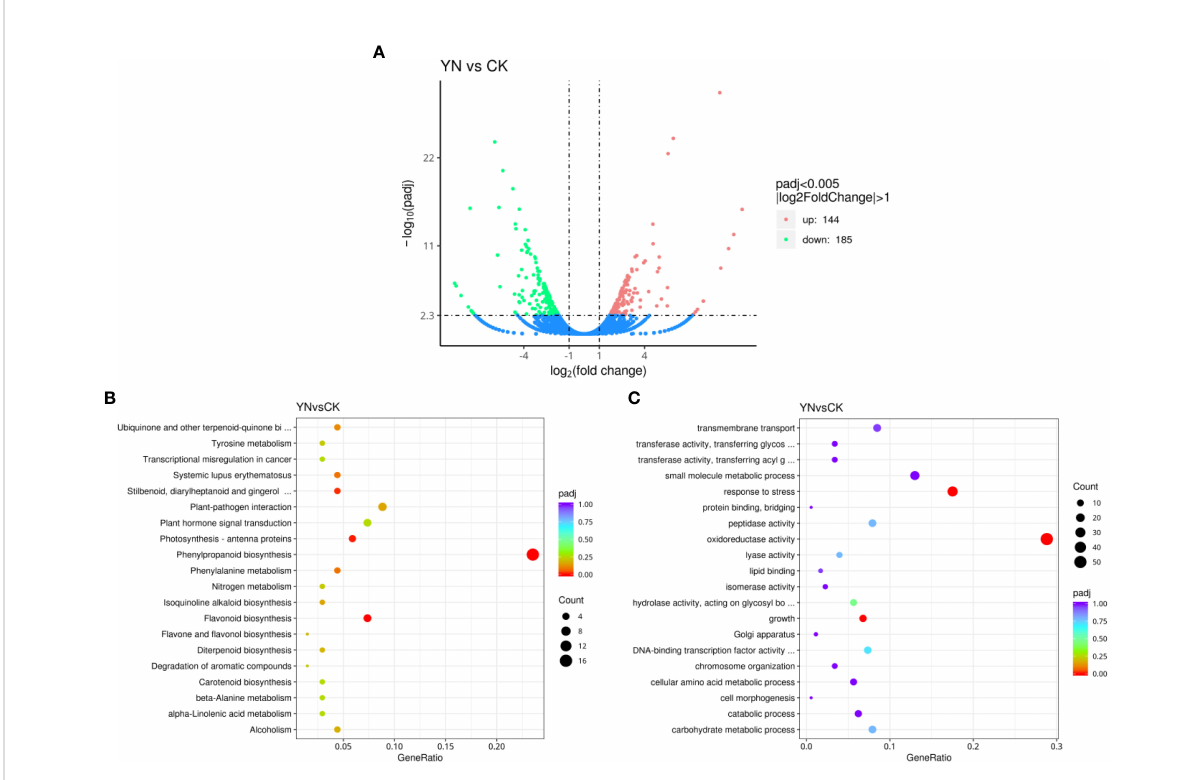
FIGURE 5 Numbers of differentially expressed genes (DEGs) in duckweed between YN (in response to streptomycin) and CK (A) . KEGG (B) and GO (C) pathway enrichment for DEGs in YN vs .